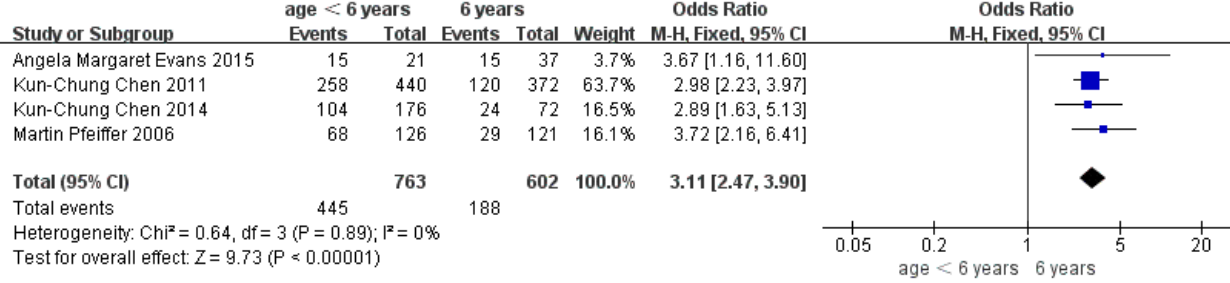
Figure 3. The forest plot of age 6–9 years for flatfoot in children [7,11,13,17].